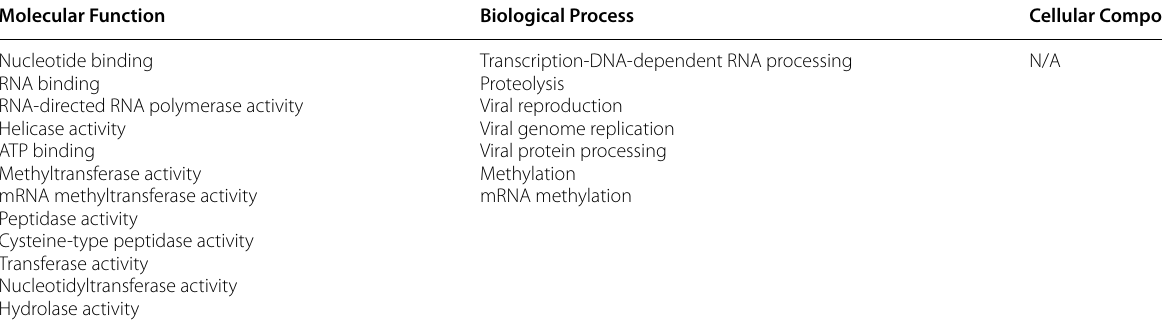
Table 6 Functional annotation returned by CELLO2GO for Y-domain Molecular